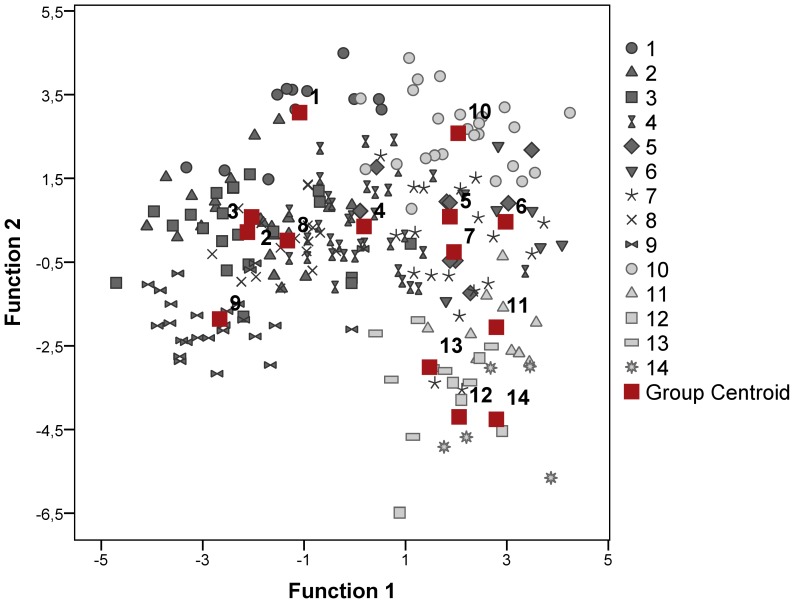
Vocal individuality in pant calls of southern white rhinos recorded in various social contexts.The plot shows the first two canonical discriminant functions with the centroid values of pant calls for each animal. 1 = Ada, 2 = Kathi, 3 = Kifaru, 4 = Munyani, 5 = Yeti, 6 = Malia, 7 = Tamu, 8 = Naja, 9 = Zanta, 10 = Natal, 11 = Medupi, 12 = Lekoto, 13 = M06, 14 = Bert.